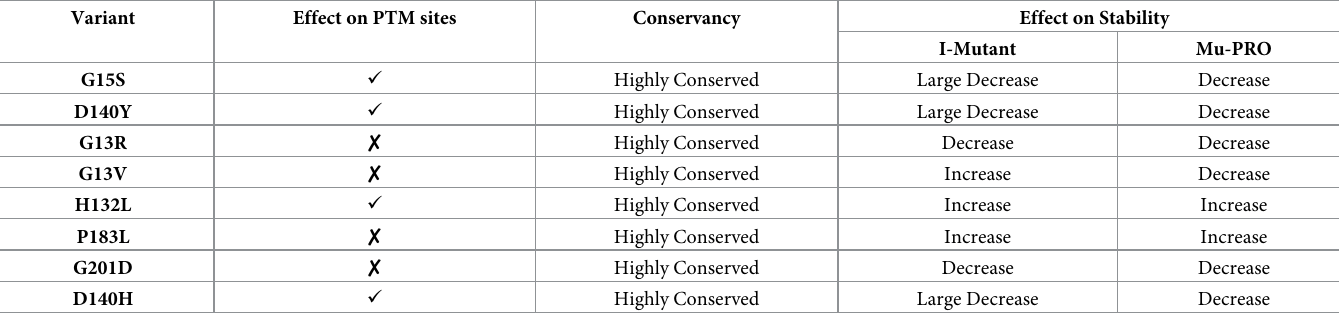
Table 1. Selection of final nsSNPs for structural analysis based on combination of effect on PTM sites, conservancy and stability analysis in 2 nd filtration.